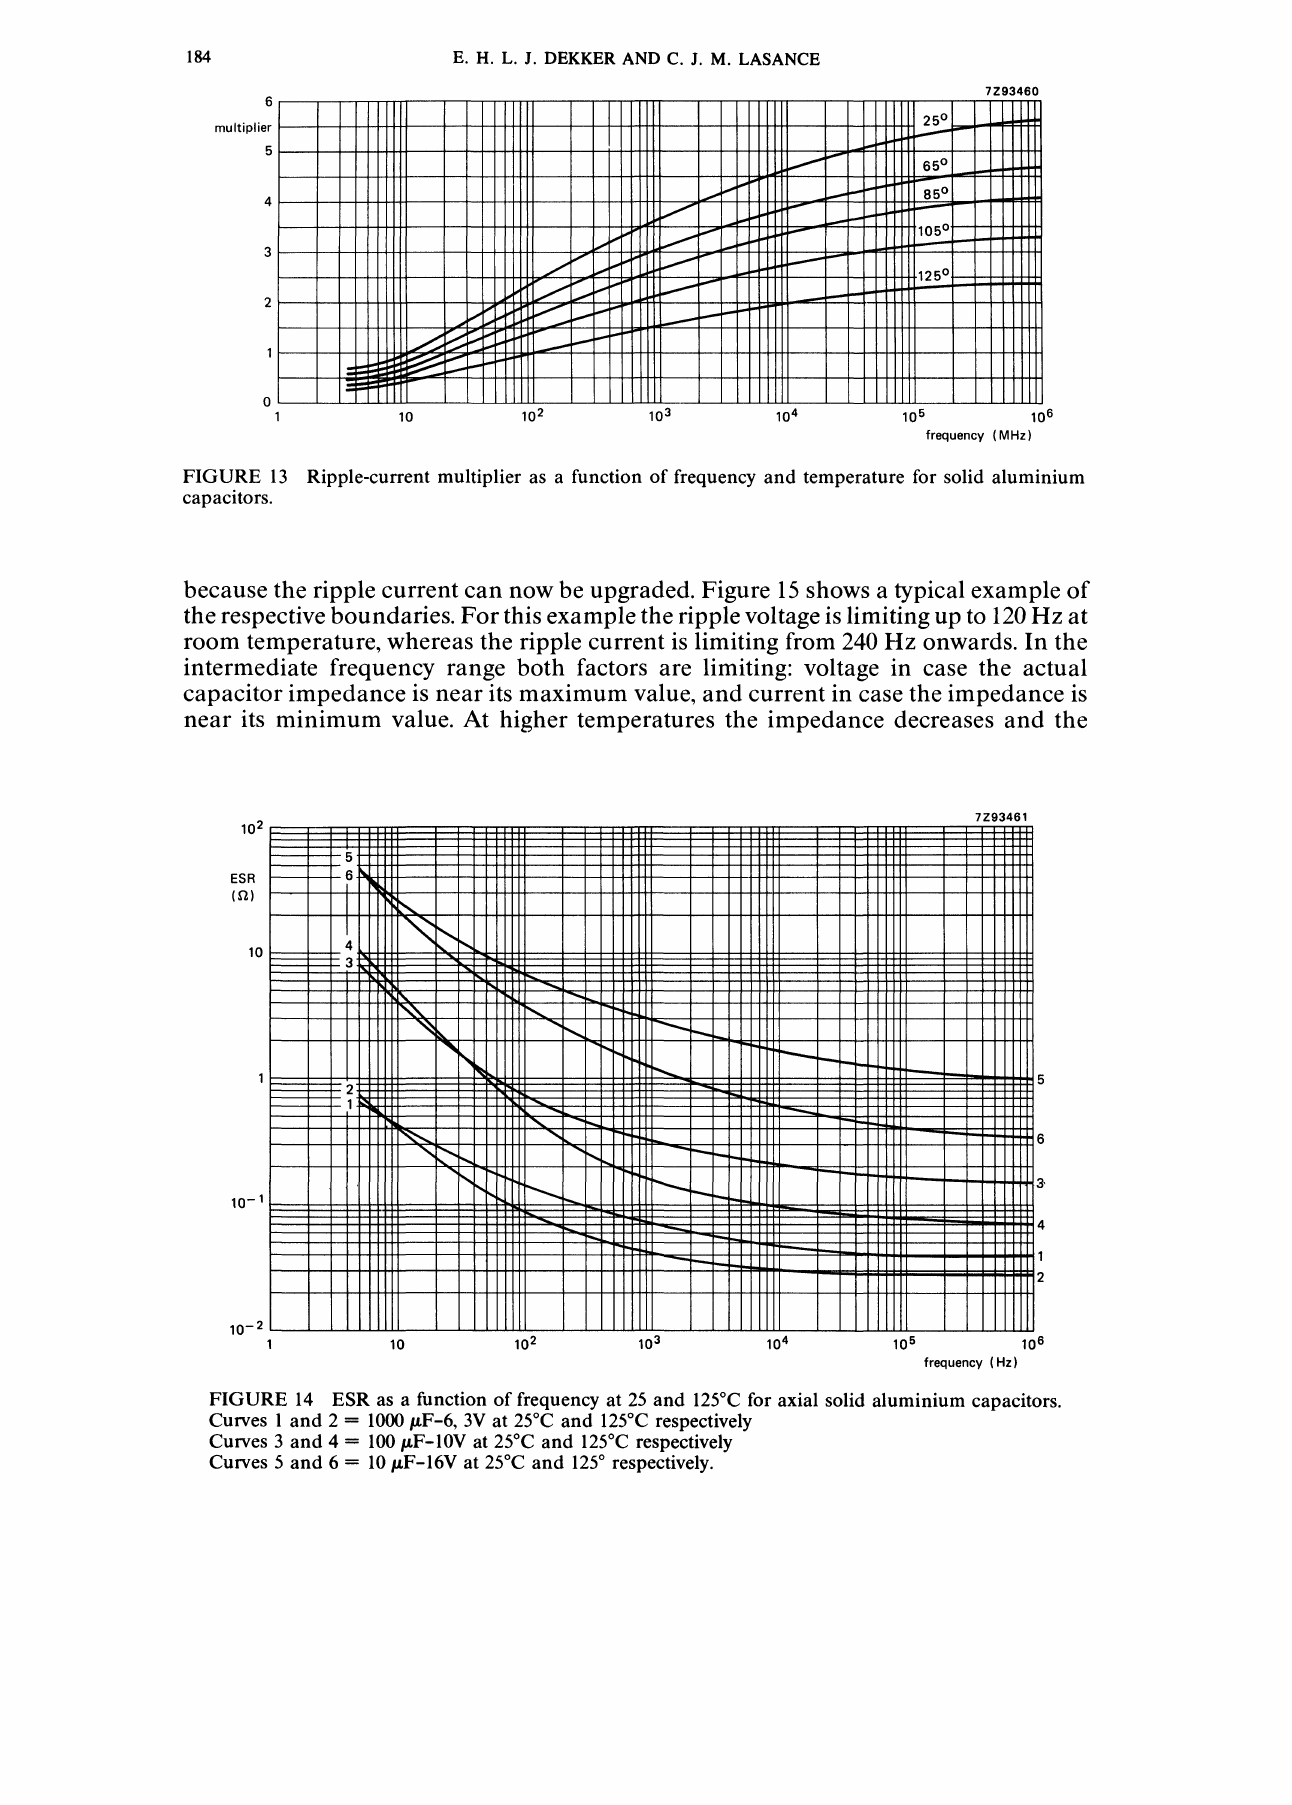
FIGURE 14 ESR as a function of frequency at 25 and 125C for axial solid aluminium capacitors. Curves and 2 1000 F-6, 3V at 25C and 125C respectively Curves 3 and 4 100 F-10V at 25C and 125C respectively Curves 5 and 6 10 btF-16V at 25C and 125